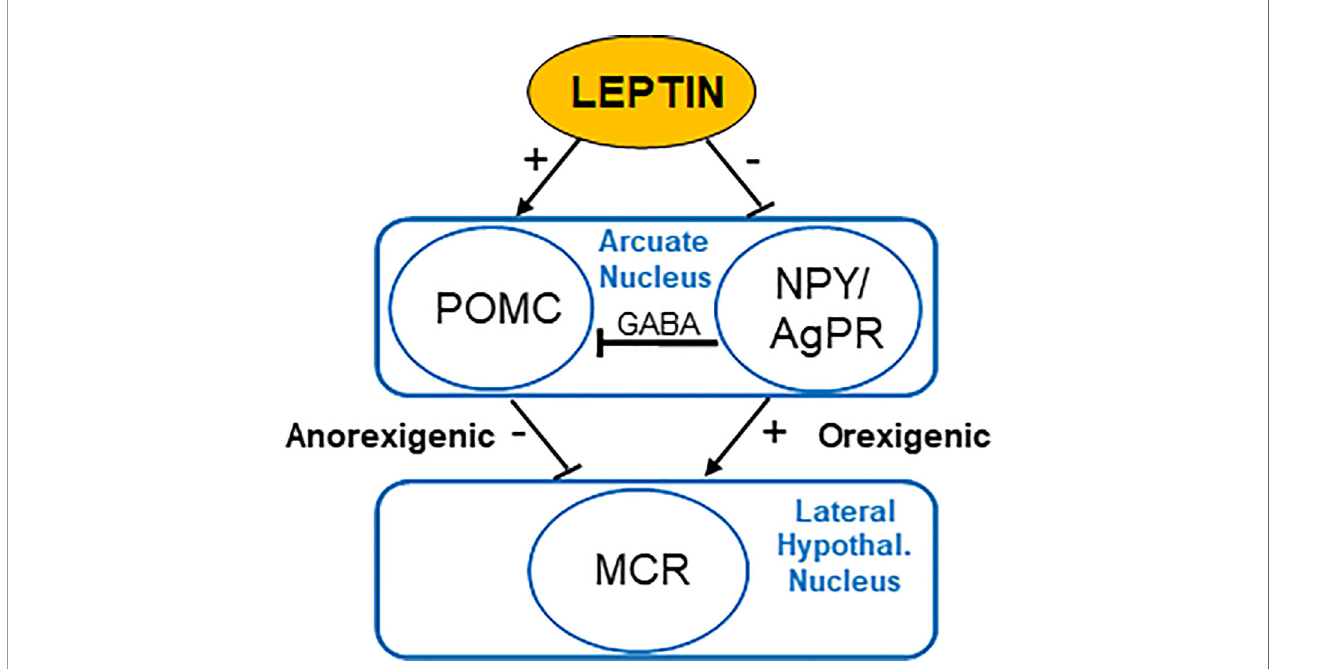
FIGURE 1 | Regulation of appetite by leptin acting on the nucleus arcuatus of the hypothalamus. POMC, proopiomelanocortin; NPY, neuropeptide Y; AgRP, agouti- related protein; MCR, melanocortin receptors; GABA, g -aminobutyric